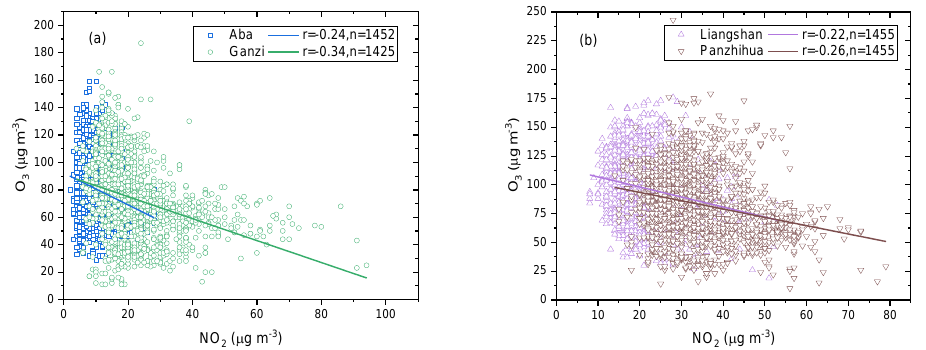
Figure 13. Correlation between NO 2 and O 3 in the ( a ) ecological zone and ( b ) economic zone in 2015 – 2018.